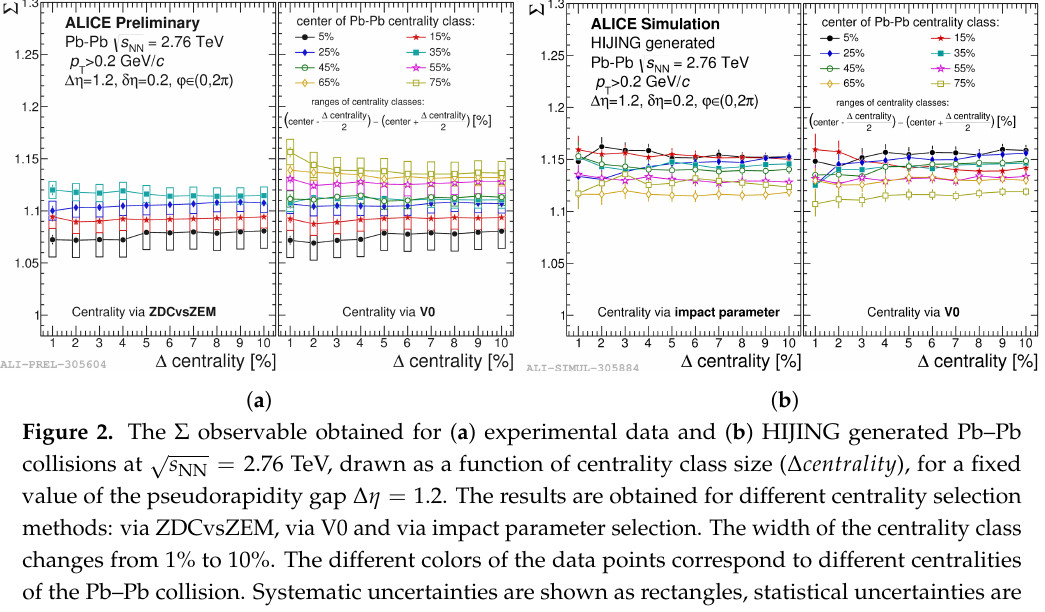
Figure 2. The Σ observable obtained for ( a ) experimental data and ( b ) HIJING generated Pb–Pb √ s NN = 2.76 TeV, drawn as a function of centrality class size ( ∆ centrality ), for a fixed collisions at value of the pseudorapidity gap ∆ η = 1.2. The results are obtained for different centrality selection methods: via ZDCvsZEM, via V0 and via impact parameter selection. The width of the centrality class changes from 1% to 10%. The different colors of the data points correspond to different centralities of the Pb–Pb collision. Systematic uncertainties are shown as rectangles, statistical uncertainties are labeled with vertical